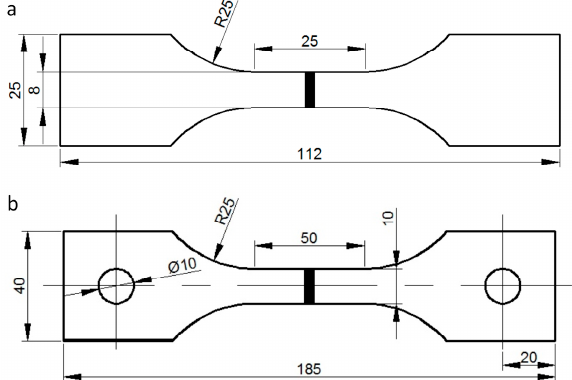
Figure 1. Dimensions of the dog-bone specimens used for tensile testing: ( a ) sample design for room temperature testing; ( b ) sample design for high temperature testing. (Unit: mm).